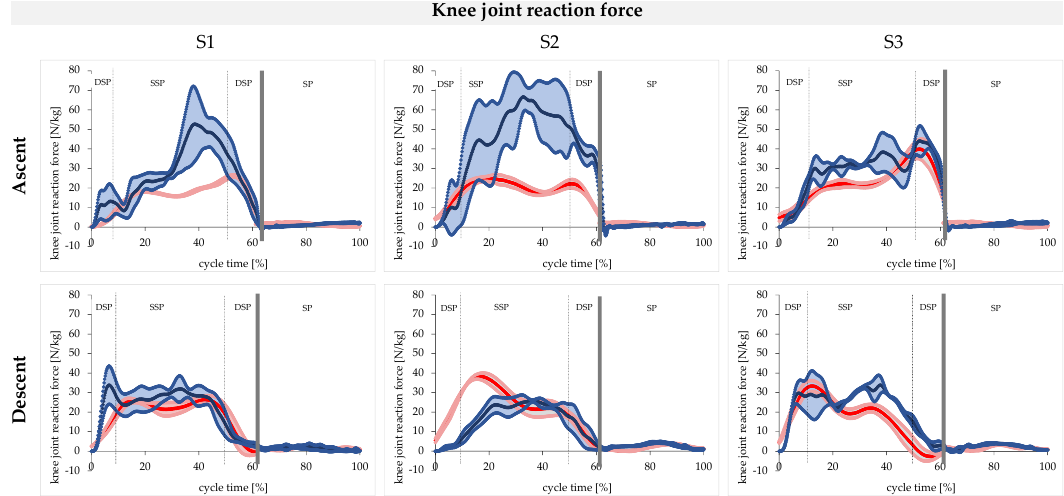
Figure 9. Knee joint reaction force (proximal-distal) for ascent and descent without (red) and with (blue) the exoskeleton for Subject 1 ( left ), Subject 2 ( middle ), and Subject 3 ( right ); DSP = double stance phase, SSP = single stance phase, SP = swing phase.